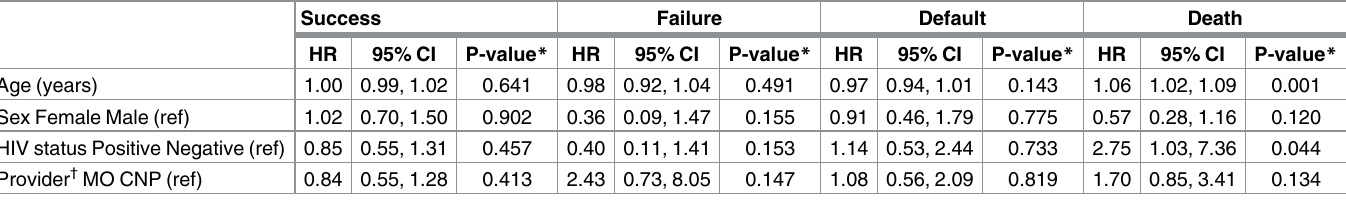
Table 3. Multivariate Cox proportional harzard model on time to one of the four treatment outcomes for comparison of cause-specific hazard between provider type. Success